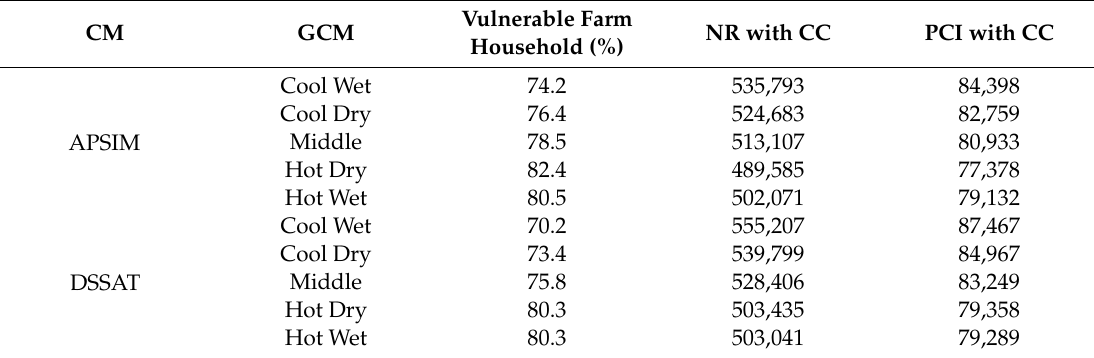
Table 6. Climate change impact on socio-economic factors in aggregate data for RCP 4.5.